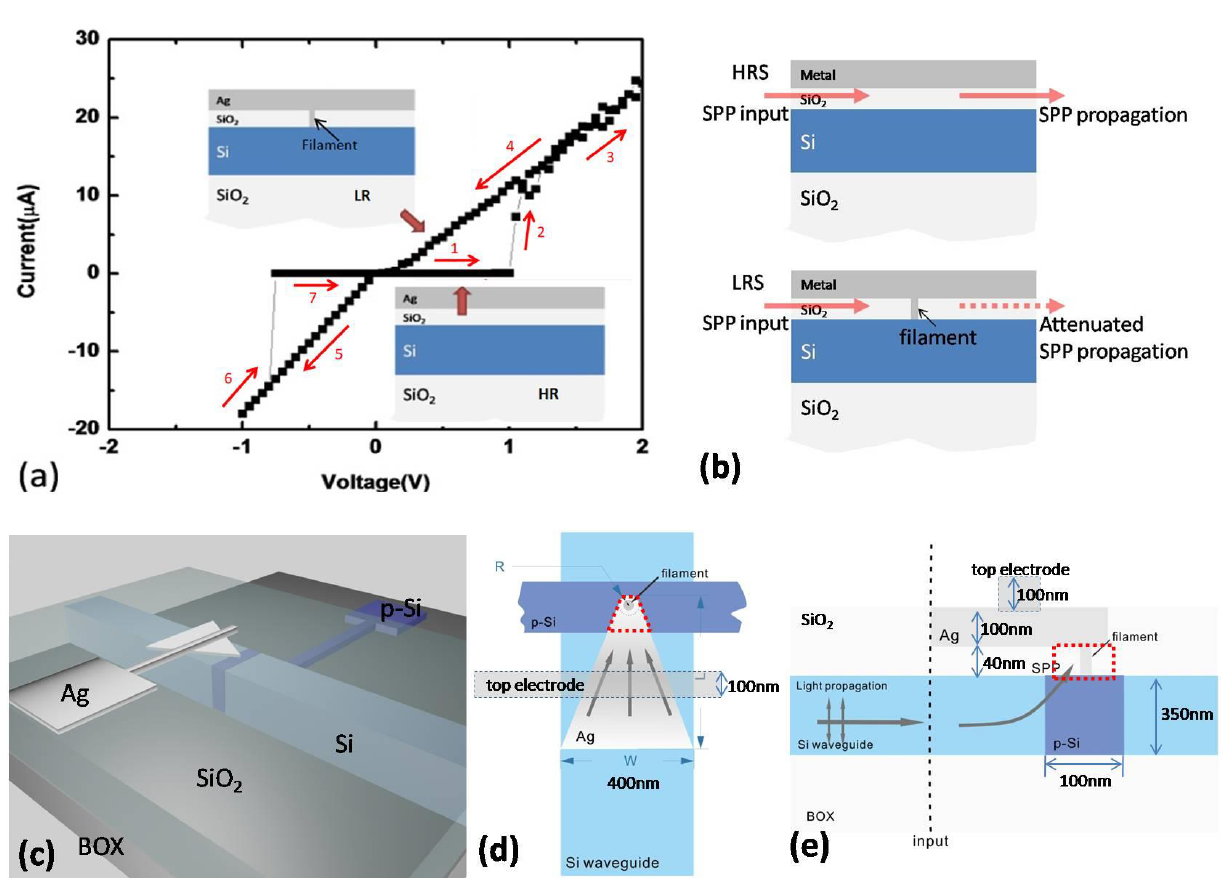
Figure 1. ( a ) Memristive behaviors of Ag/SiO 2 /Si trilayer system; ( b ) conceptual illustration of the distinct interaction between plasmon and memristor at HR (upper) and LR (bottom) state; ( c ) three-dimensional visualization of the designed plasmonic memristor based on triangle-shaped metal taper on top of a dielectric wave guide (BOX: buried oxide); ( d ) top view; and ( e ) side view of the plasmonic memristor.